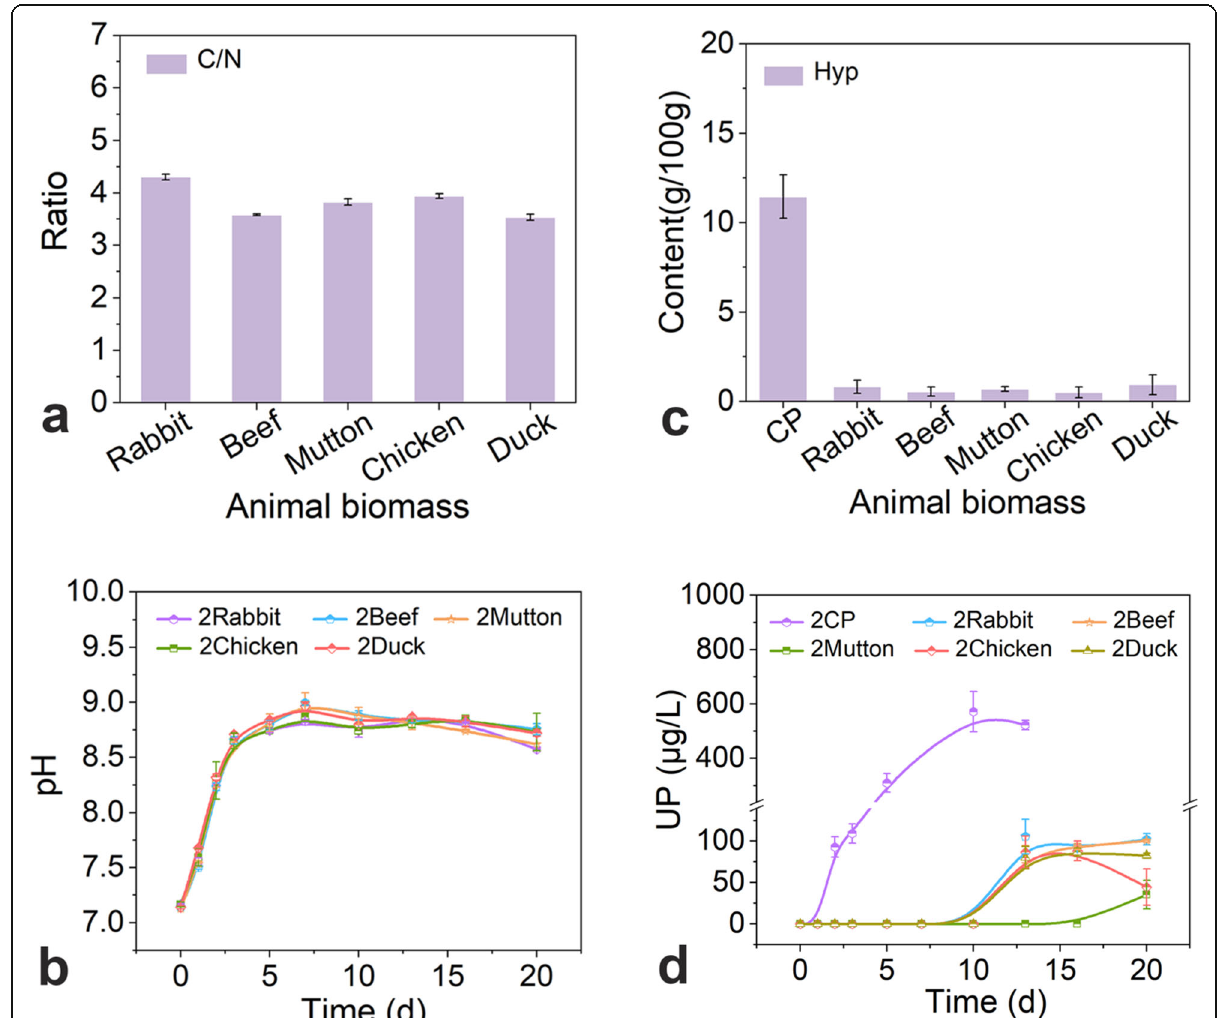
Fig. 5 Fermentation performances of meat hydrolysates by S. coelicolor . a The C/N ratio of the meat hydrolysates of rabbit, beef, mutton, chicken, and duck. b The variations of pH values in the 2Rabbit, 2Beef, 2Mutton, 2Chicken, and 2Duck media during the fermentation period of 20 d. c The contents of Hyp in the animal biomasses of CP and these meat hydrolysates. d The variations of UP concentrations in these media, during the fermentation process of 20